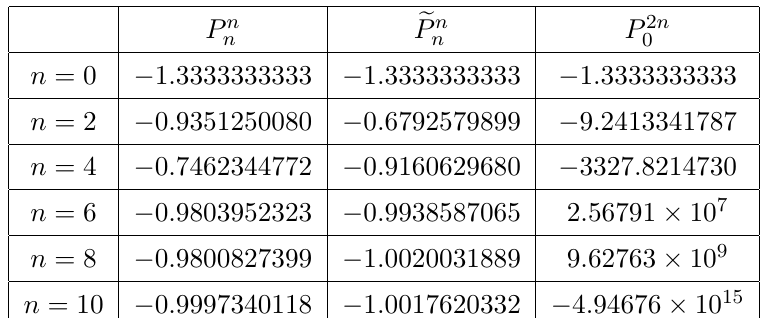
Table 1 . The Pad(cid:19)e and Pad(cid:19)e-Borel approximations for the normalized value of the kinetic term (cid:0) (cid:1) ^ E ( z ) = (cid:25) 2 z 2 tr[ z L 0 ^(cid:8) Q B z L 0 ^(cid:8) ] evaluated at z = 1. The second column shows the P n 3 approximation. The third column shows the corresponding e P n last column, P 2 n represents a trivial approximation, a naively summed 0